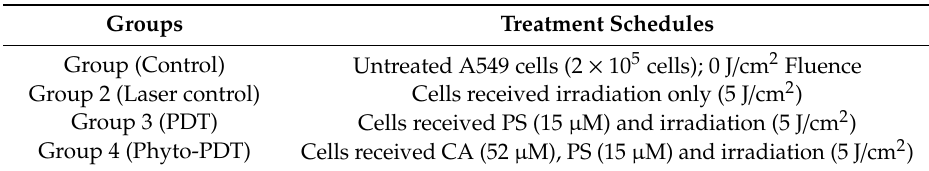
Table 2. Experimental design for the e ff ect of CA in PDT of A549 cells.